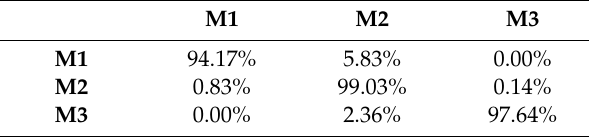
Table 3. Signal misperceptions for motors: vertical axis.